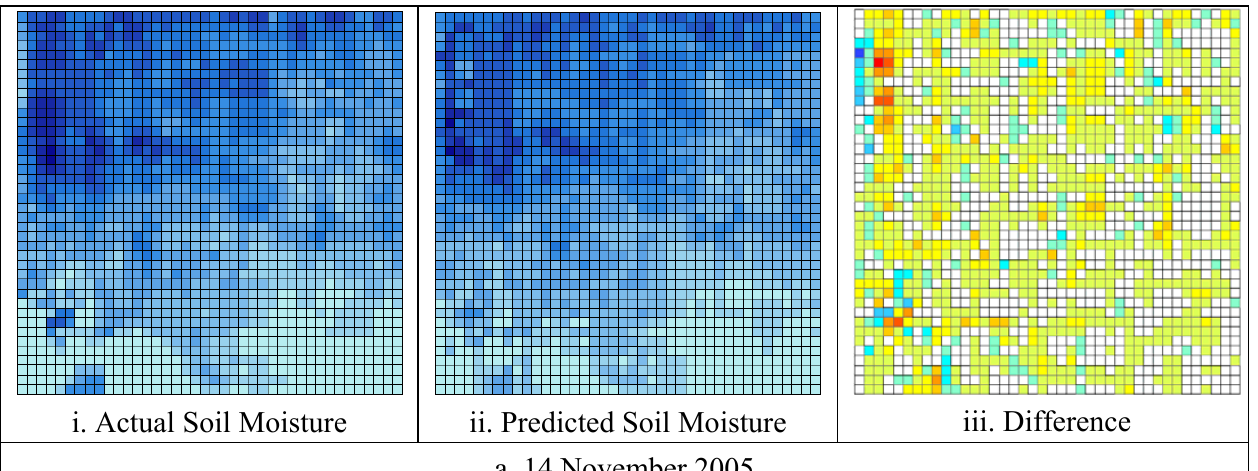
Figure 5. Actual and predicted soil moisture map at 1 km resolution on a. 14 November 2005, and b. 21 November